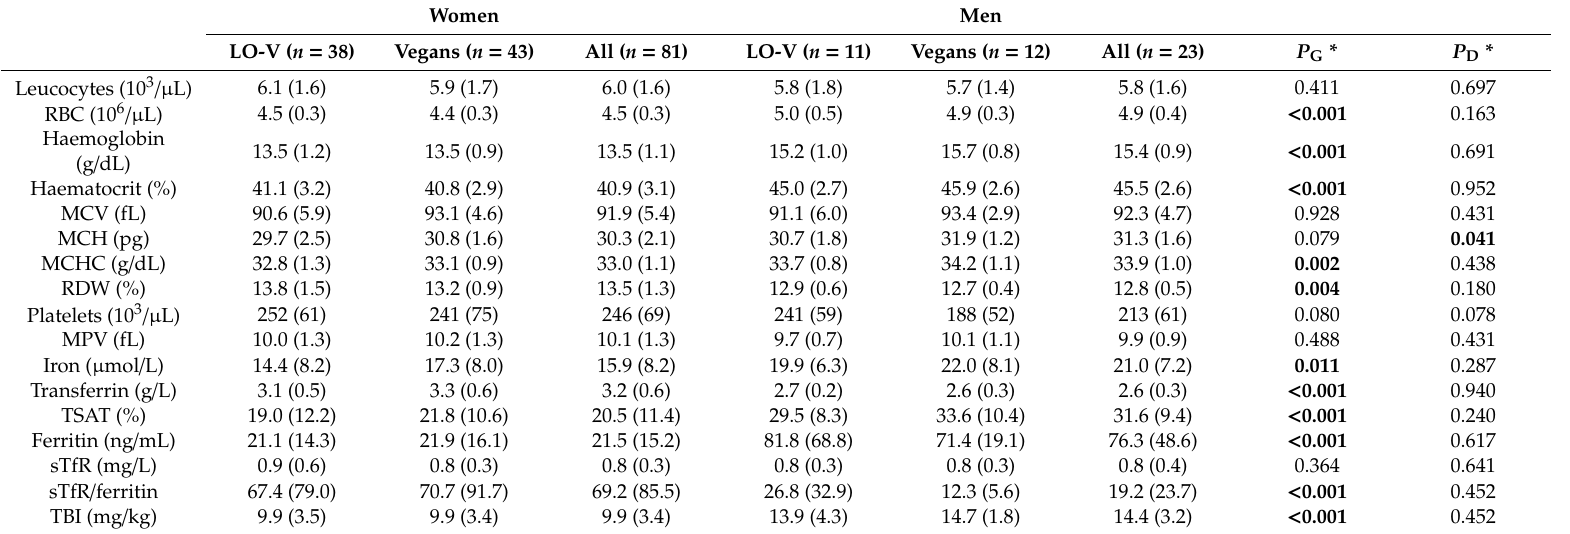
Table 2. The haematological and biochemical markers according to gender and diet